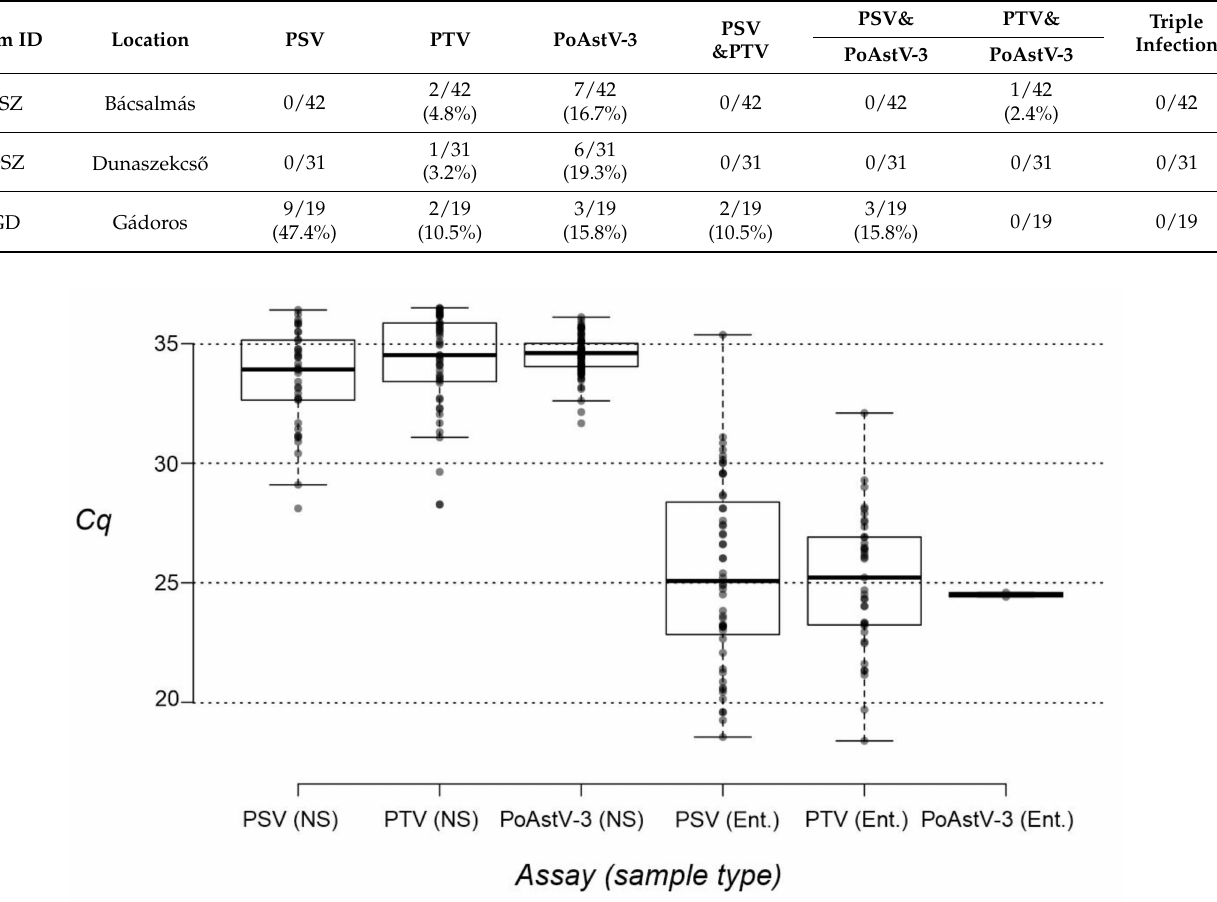
Figure 5. Box plot of measured Cq values of nasal swabs (NS) and faecal/rectal swab samples (Ent.) of porcine sapelovirus (PSV), porcine teschovirus (PTV) and porcine astrovirus type 3 (PoAstV-3). Center lines show the medians; box limits indicate the 25th and 75th percentiles as determined by R software; whiskers extend 1.5 times the interquartile range from the 25th and 75th percentiles; outliers are represented by dots; data points are plotted as gray circles. n = 37, 47, 84, 52, 39, and 2 sample